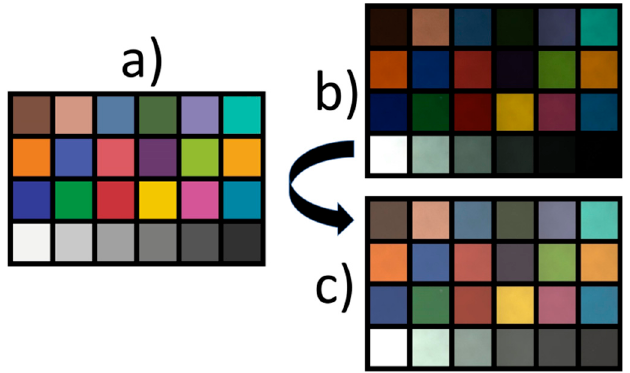
Figure 7. Color calibration: ( a ) shows a picture of the ideal RGB ( r ed, g reen, b lue) values of the ColorChecker Classic. ( b ) Shows an image the color checker and ( c ) after the image after color correction. The RGB values are now closer to the ideal RGB values in ( a ).